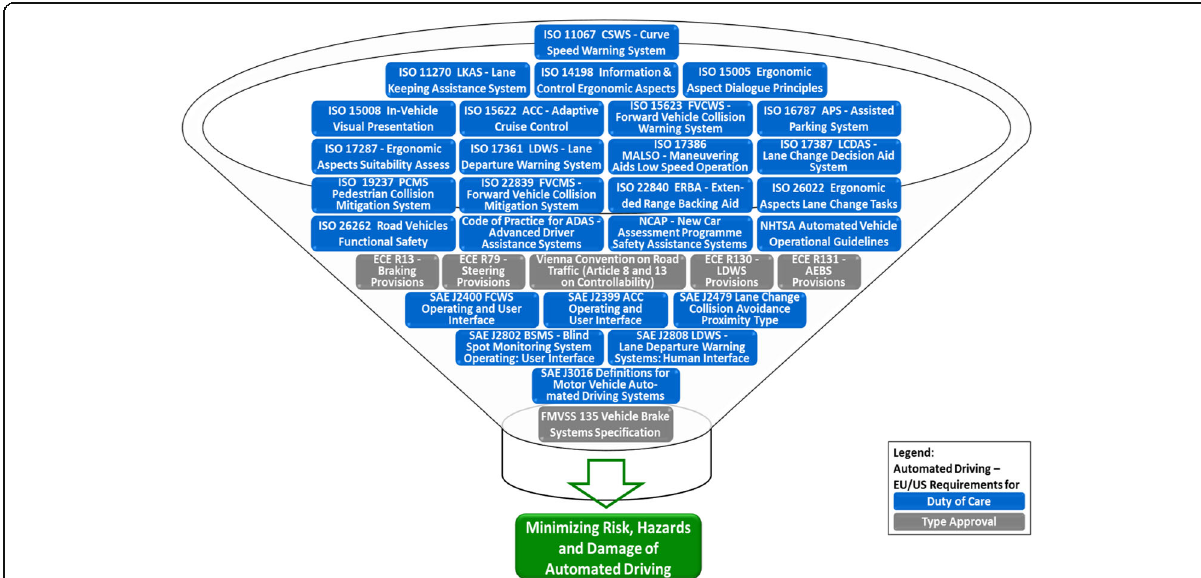
Fig. 2 Requirements for Type Approval and Duty of Care to minimize risk, hazards and possible damage of automated driving [3, 18,